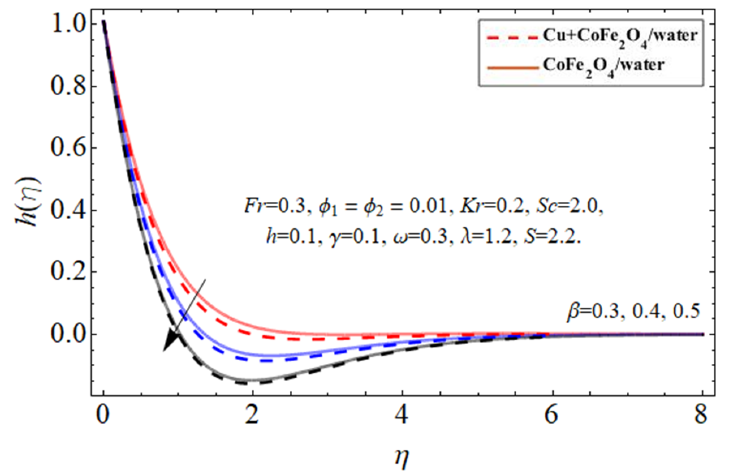
( ) ( ) η η h h against injection term β+ . against injection term β+ .